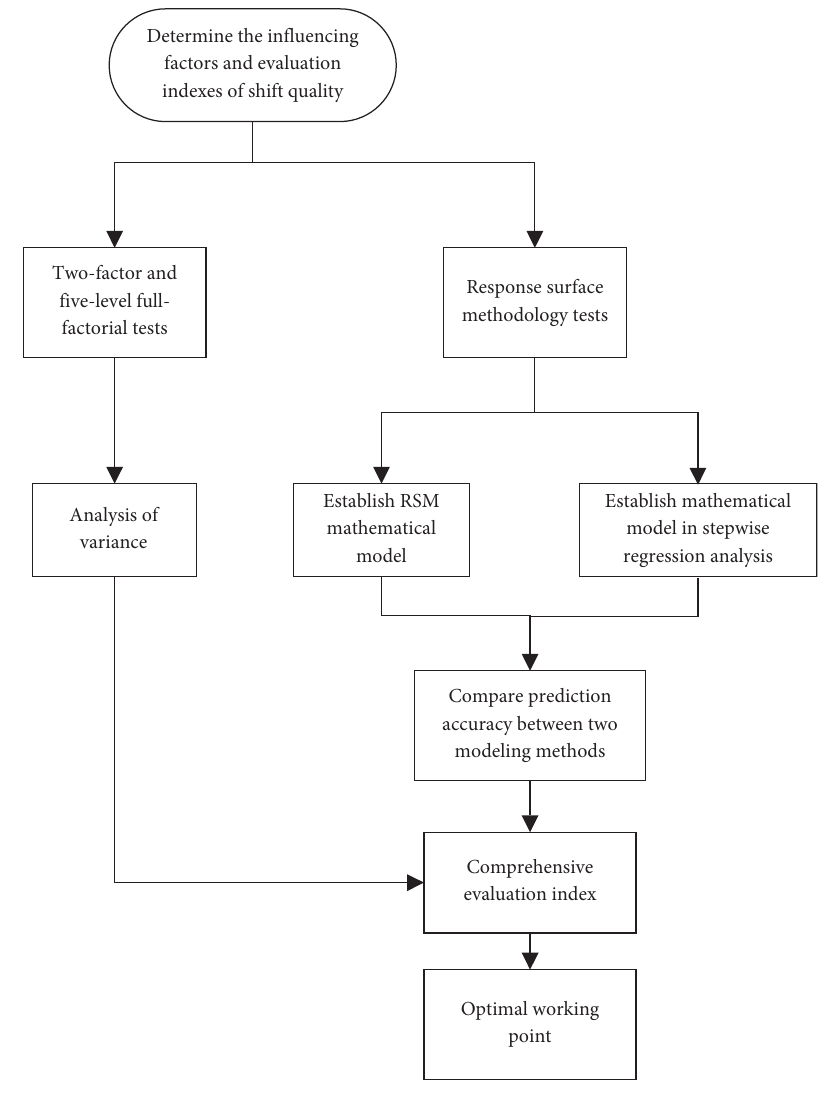
Figure 1: Technical